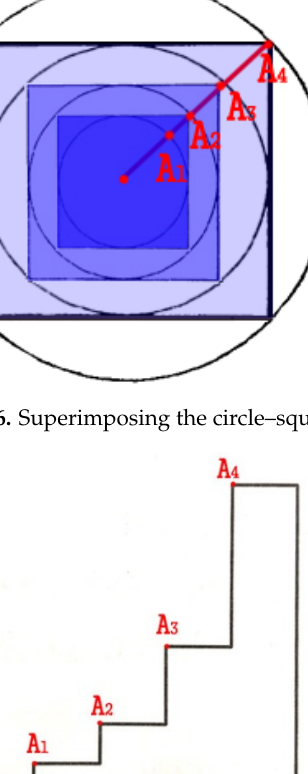
Figure 5. Song’s Yingzao Fashi circle–square diagram (upper), square–circle diagram (bottom).